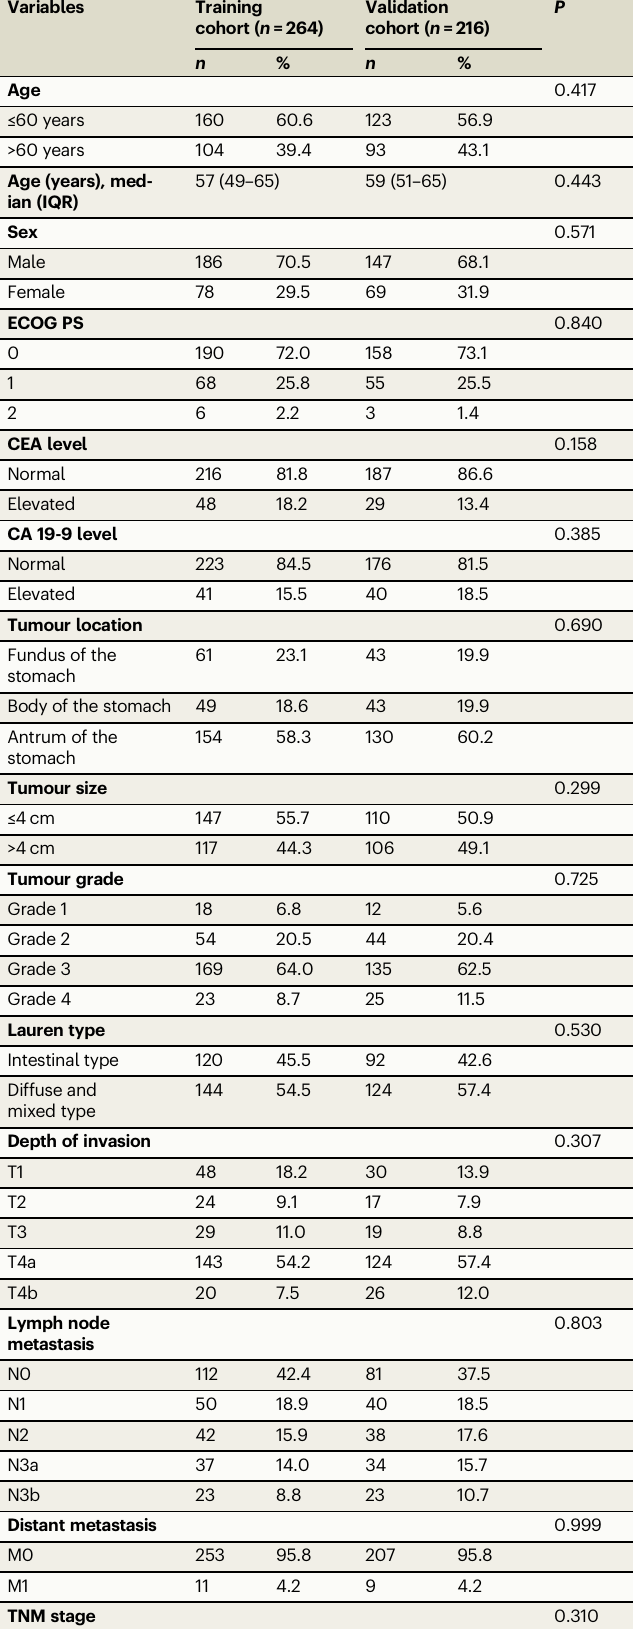
Table 1 | Characteristics of patients in the training and vali- dation cohorts